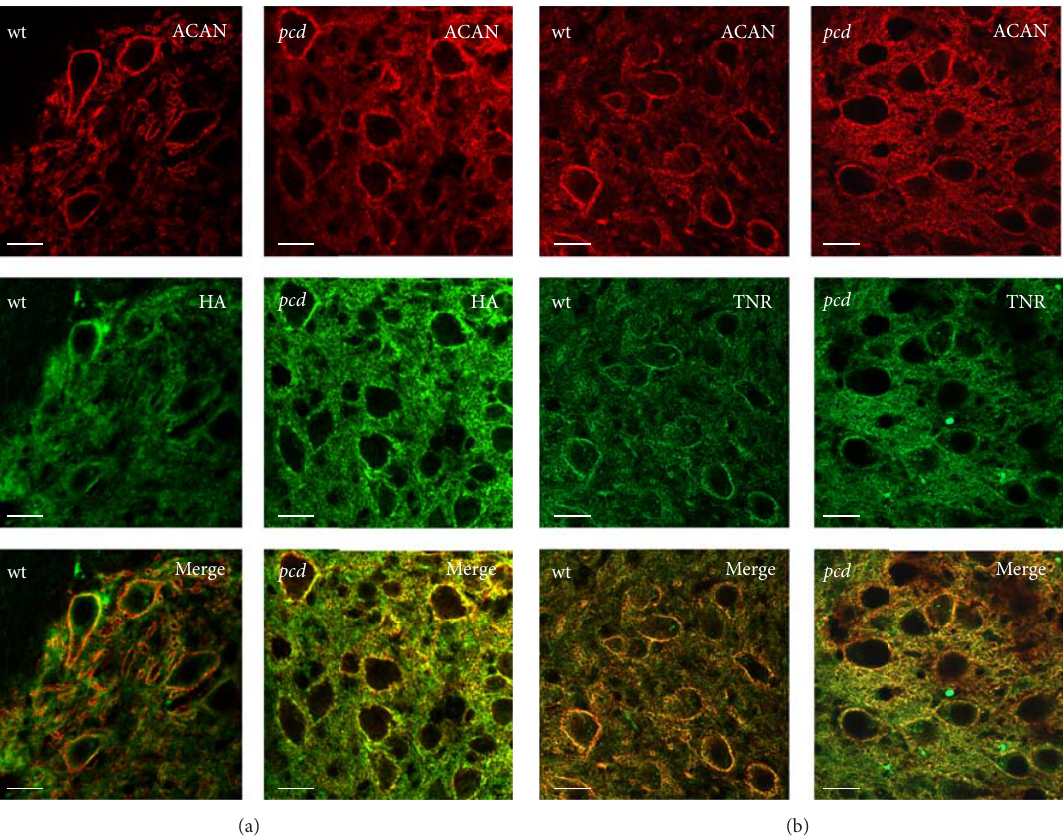
Figure 6: Distribution of hyaluronan and tenascin-R in DCN. The labeling shows important constituents of PNs. The neurons in DCN are surrounded by strong aggrecan immunoreaction (red). (a) Hyaluronan is ubiquitously distributed and concentrated around the neurons. (b) Tenascin-R is equally present in DCN of wt and pcd mice and mainly encloses the neurons. Scale bar: 20 𝜇